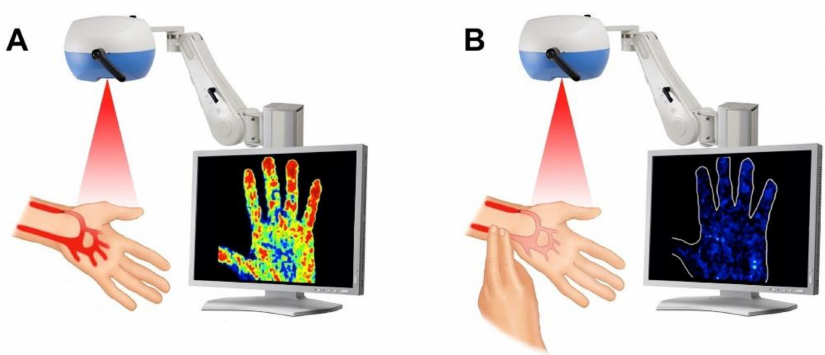
Figure 1. Description of the static Laser Doppler examination (static LDPI test).The static LDPI test was performed taking a color-coded perfusion image of the whole left hand palm in rest condition ( A ) and after ulnar occlusion ( B